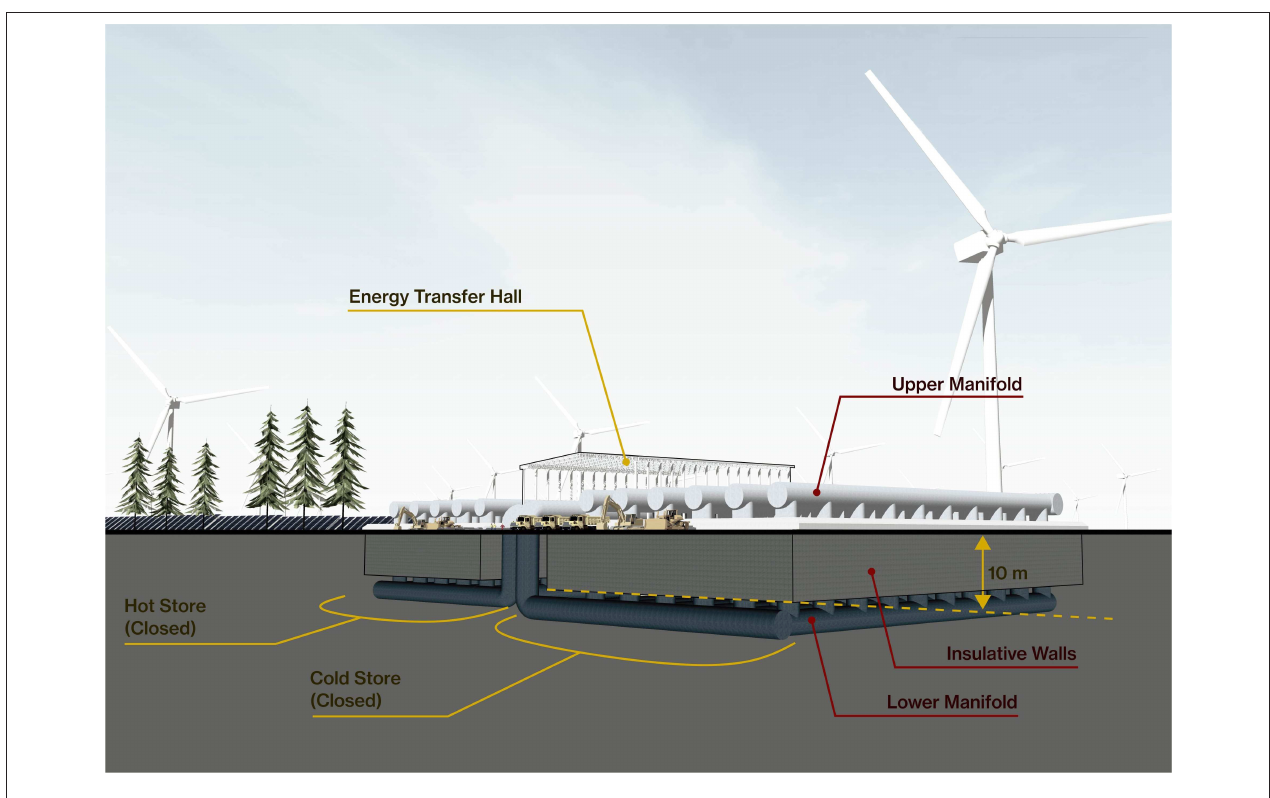
FIGURE 8 | Underground view of the facility shown in operating configuration.